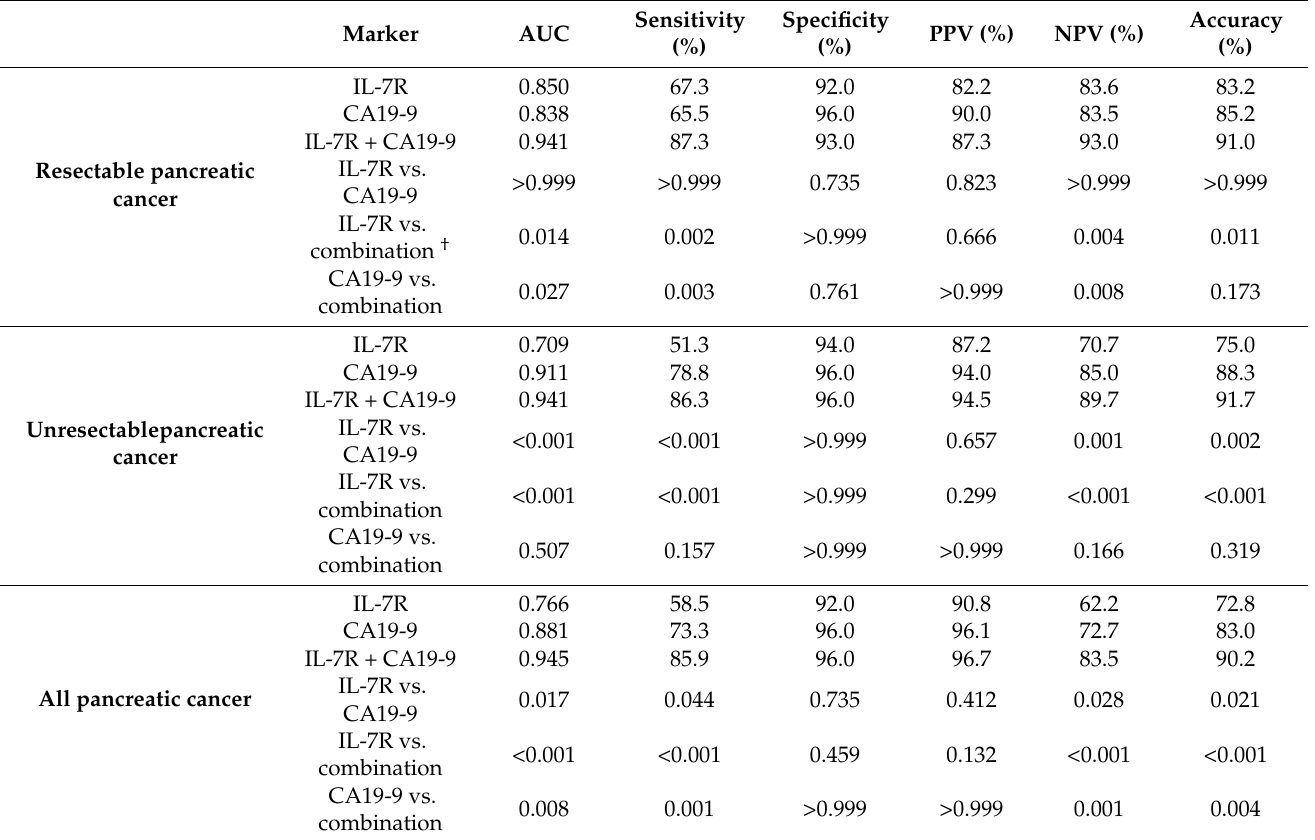
Figure 4. ROC curves for IL-7R, CA19-9, and IL-7R plus CA19-9 for PDAC assessment. ( A ) In the resectable PDAC group, AUCs for IL-7R and CA19-9 did not differ, but the AUC for IL-7R plus CA19-9 was higher than that for IL-7R or CA19-9 alone. ( B ) In the unresectable PDAC group, the AUCs for CA19-9 alone and in combination with IL-7R were higher than that for IL-7R alone. ( C ) In the resectable and unresectable PDAC groups, the AUC for IL-7R combined with CA19-9 was higher than those for IL-7R and CA19-9 alone. Table 2. Diagnostic performance of IL-7R and CA19-9 alone and combination for pancreatic adeno- carcinoma (PDAC).